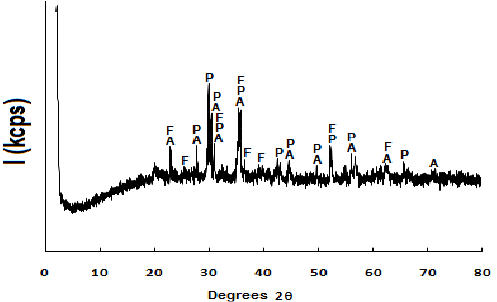
Fig.1. X-ray diffraction spectra of volcanic tuff.[A: Plagioclase feldspar (Anorthite), F: Olivine (Forsterite) and P: Pyroxene (Augite)], Analysis in Royal Scientific Society Labs (April, 2014) T ABLE 1: C HEMICAL C OMPOSITION OF V